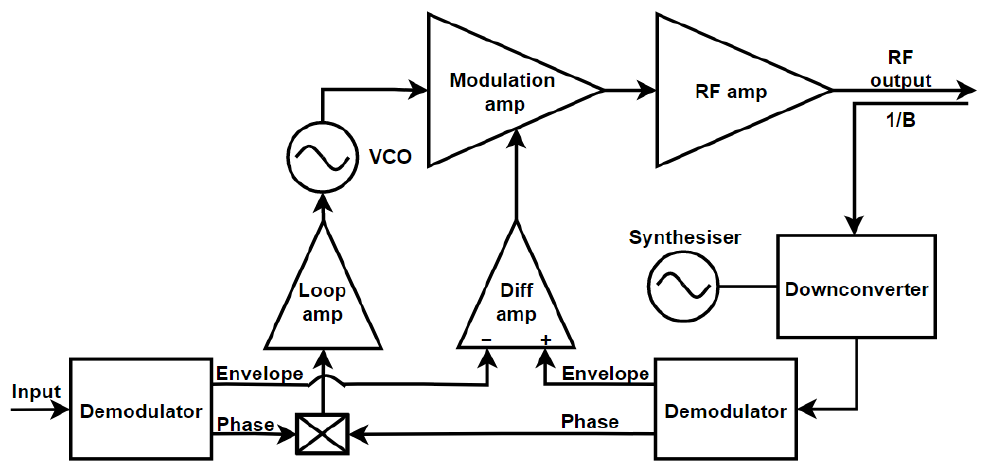
Figure 6. Polar feedback transmitter operational diagram.